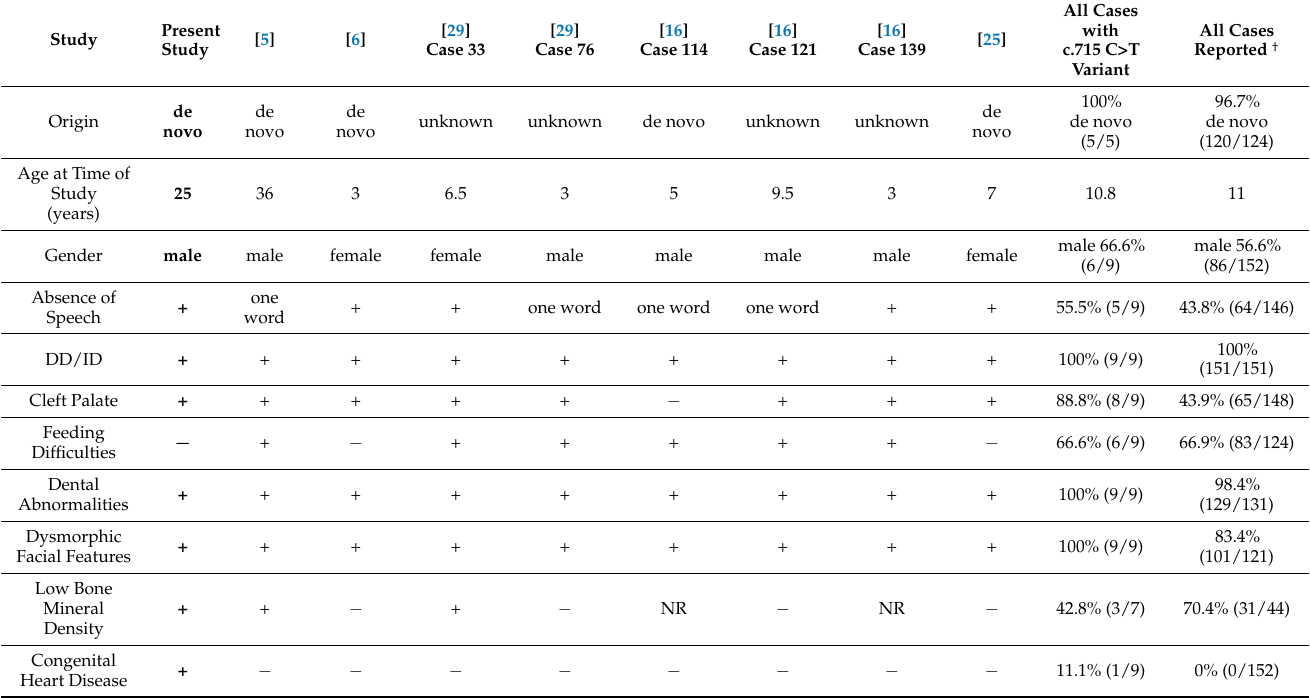
Table 1. Comparison among individuals with SAS-related disorders due to SATB2 :c.715C>